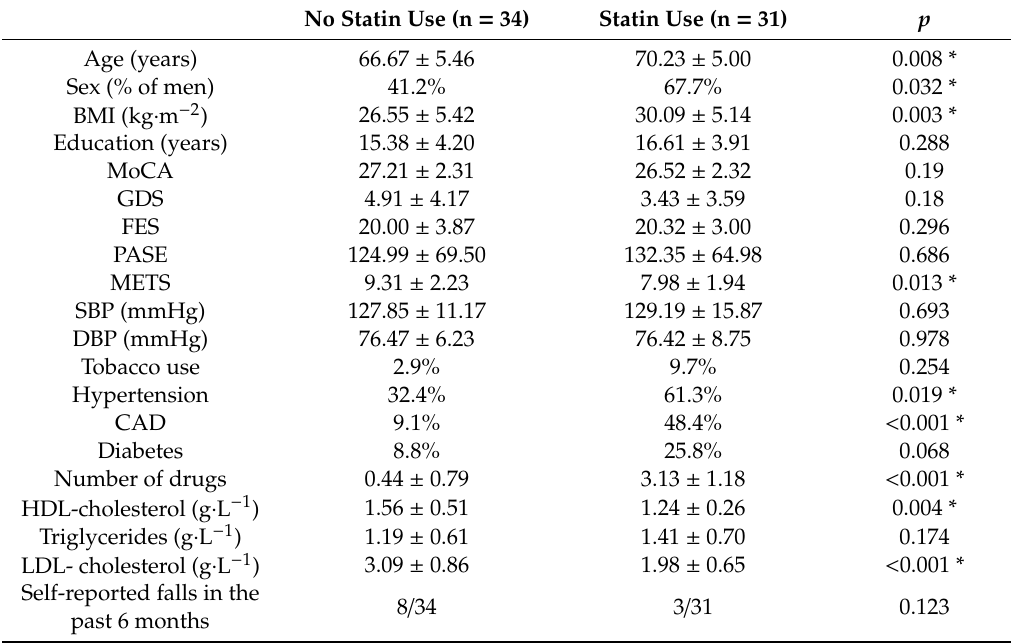
Table 1. Participants characteristics (means ± standard deviations for continuous variables or percentages for binomial